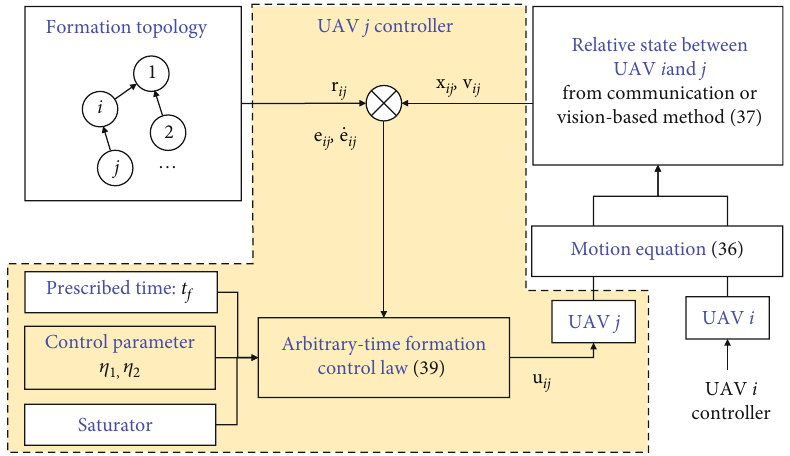
Figure 4: The diagram of the proposed arbitrary time convergence formation